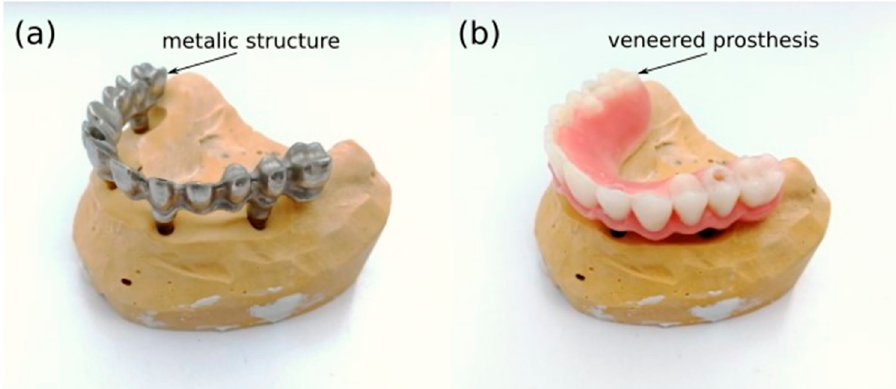
Figure 1. Dental prosthesis after metallic structure manufacturing ( a ) and in final form after veneering processes ( b ).